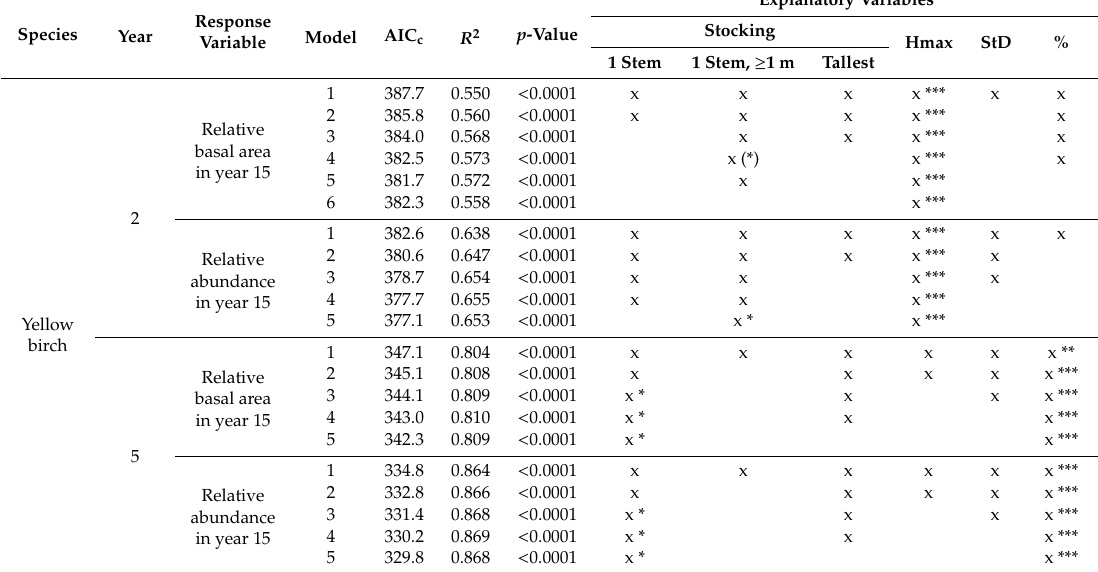
Table 3. Results of the model selection approach for yellow birch. Response variables were chosen from year-15 regeneration indices that represented relative presence of a species within a canopy